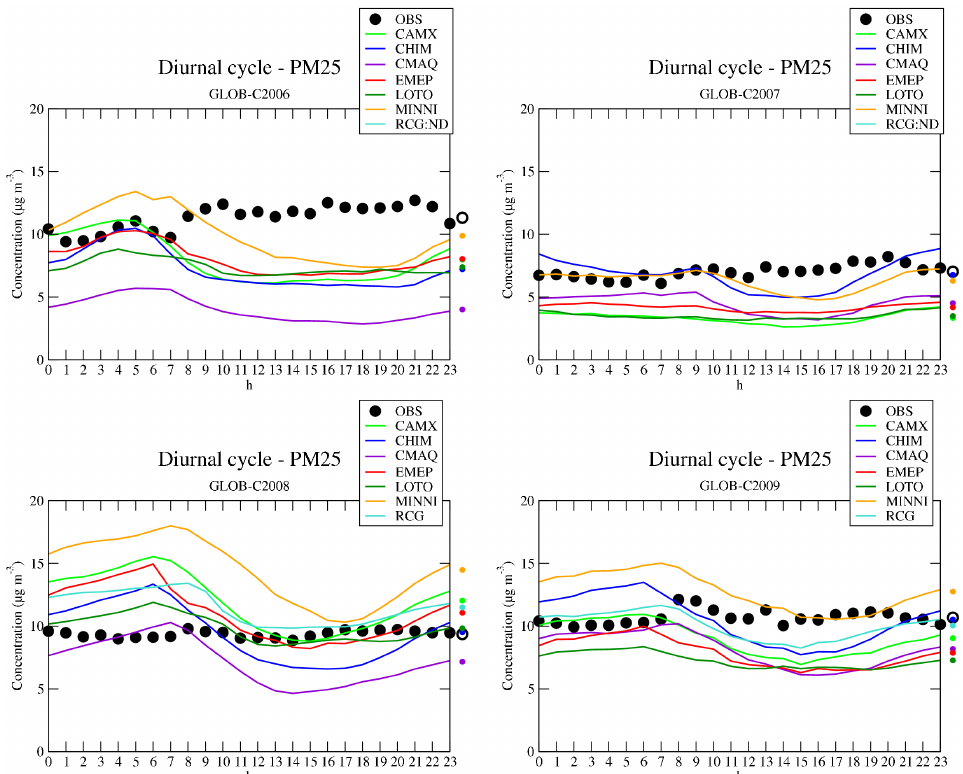
Figure 16. Mean diurnal cycles of PM 2 . 5 for all campaigns simulated by the models compared with observations. Averaged concentrations are provided on the right side of the